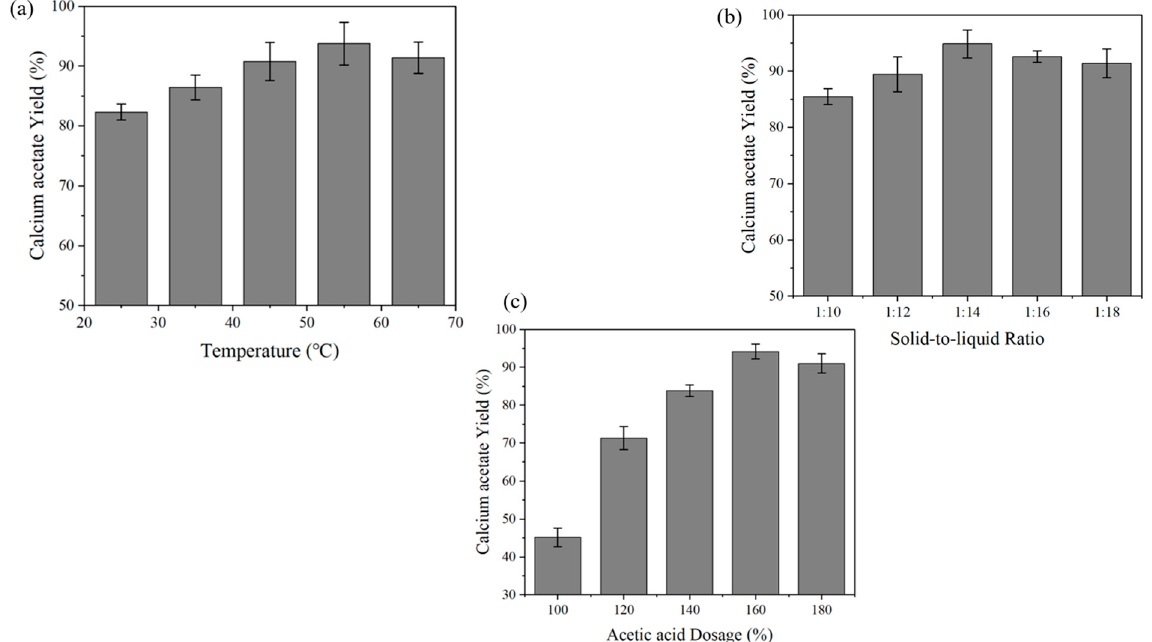
Figure 2. Yields of calcium acetate under a different ( a ) reaction temperature, ( b ) solid-liquid ratio, and ( c ) acetic acid dosage conditions, showing that when the other two factors were fixed, the yield of calcium acetate reached a peak when the temperature, solid-liquid ratio, and acetic acid dosage were 55 °C, 1:14, 160%, respectively. The acetic acid dosage had the greatest influence on the calcium acetate yield, while the temperature had relatively little influence, which was the same as the result of the response surface analysis below.